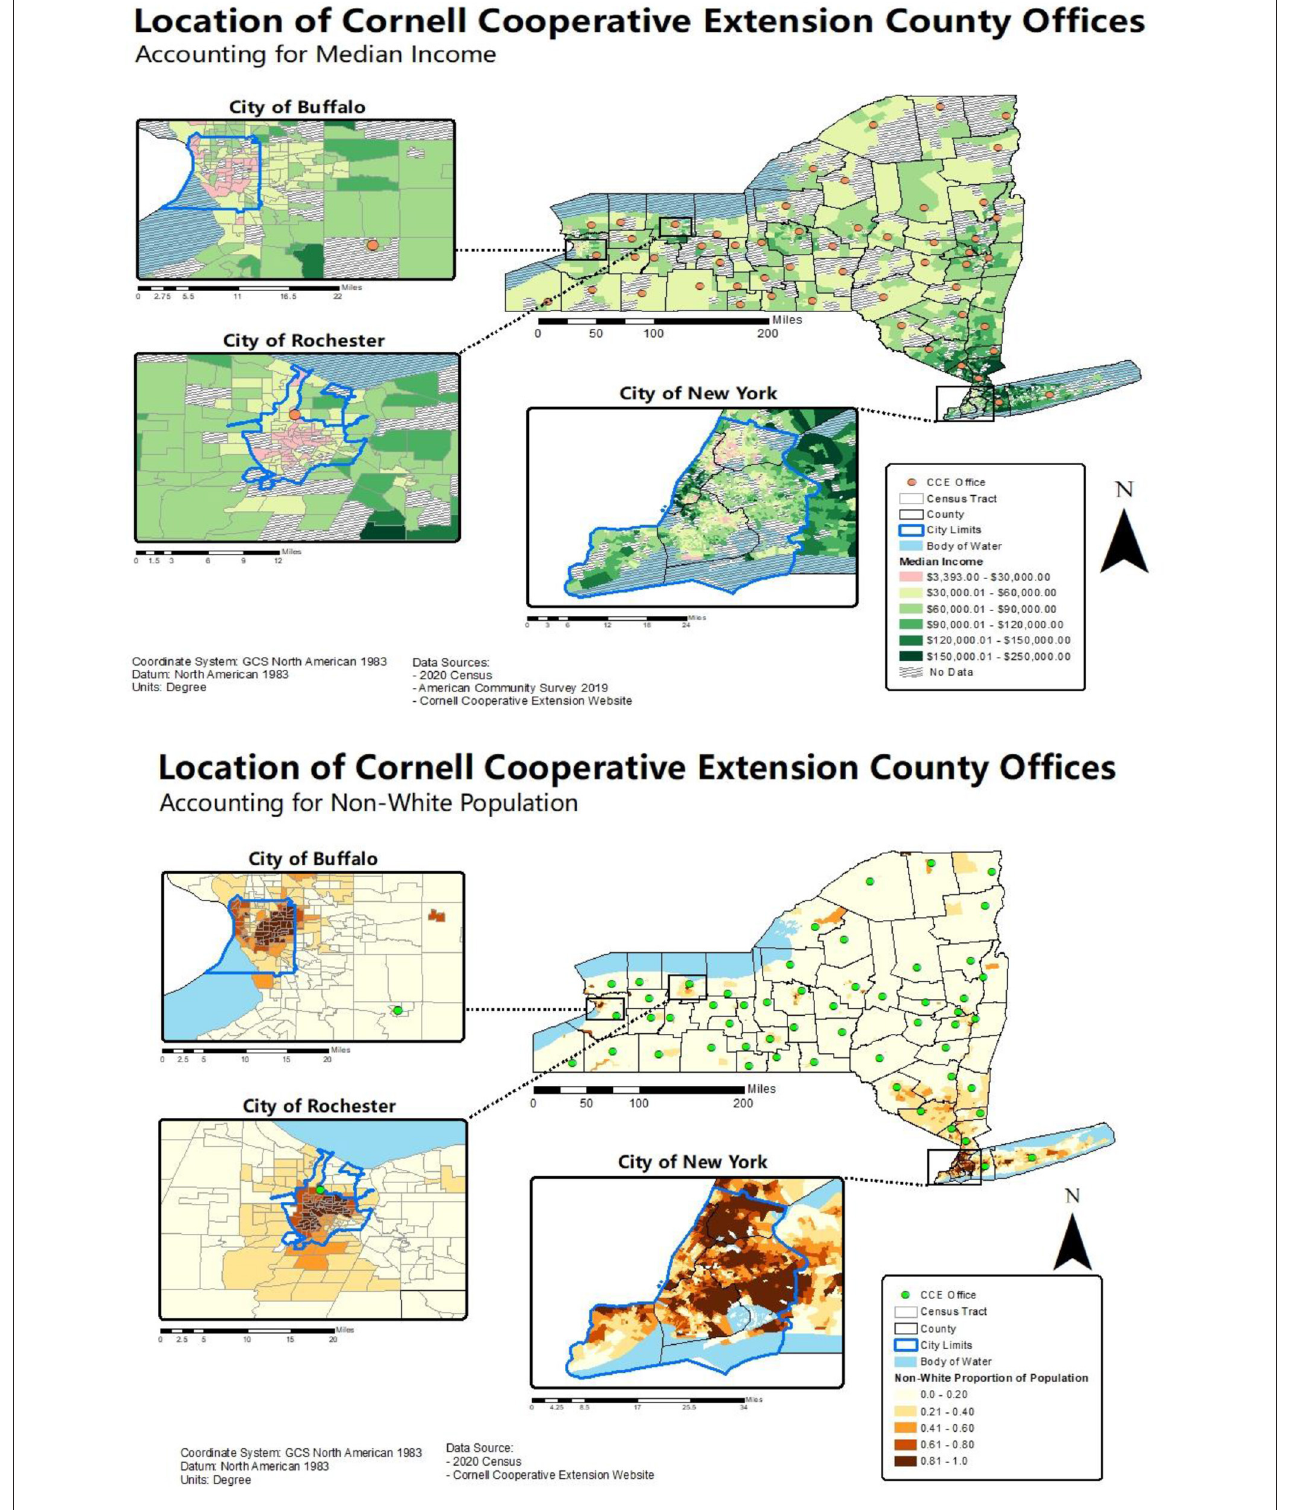
FIGURE 1 | Location of Cornell Cooperative Extension offices in New York State. While spread across the state in over 55 counties, the extension offices are largely absent in the most populous regions with the greatest percentages of non-White residents. Population data are based on the U.S. Census Bureau demographics for NYS (2020) (U.S. Census Bureau, 2019).